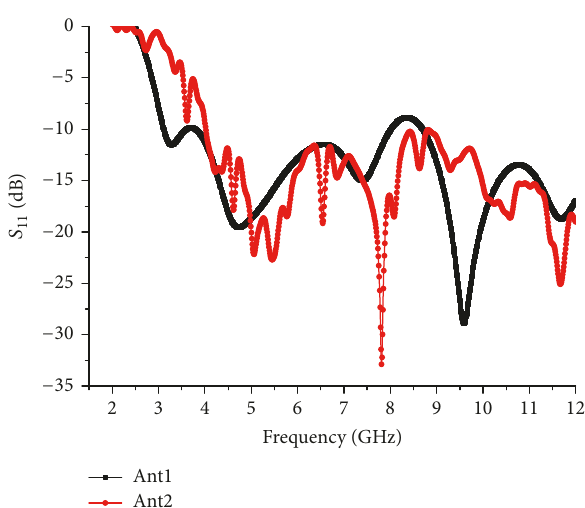
Figure 9: Return loss for Ant1 and